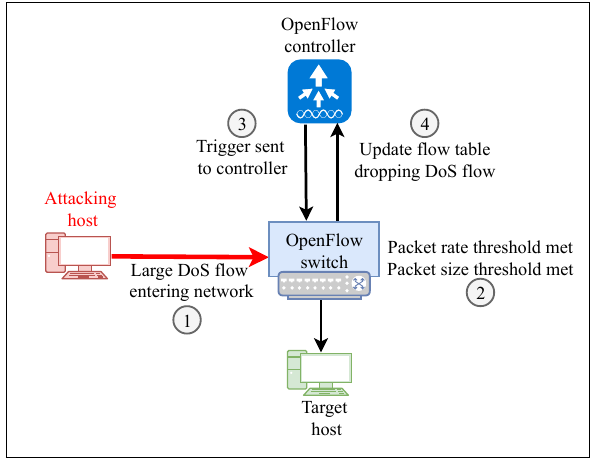
Figure 2. DoS Attack Mitigation Scheme